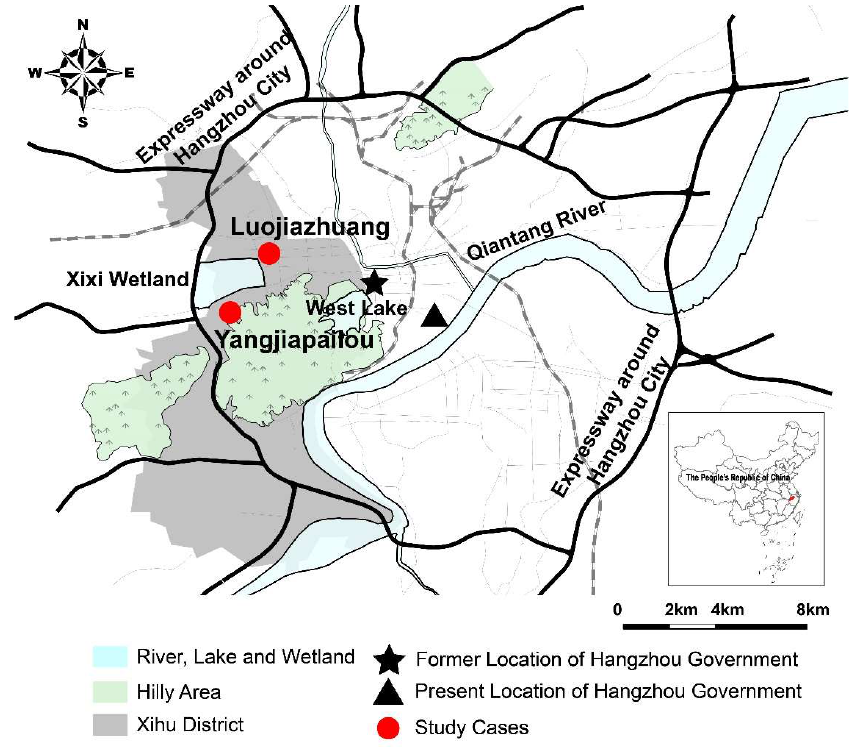
Figure 5. Locations of Luojiazhuang and Yangjiapailou.